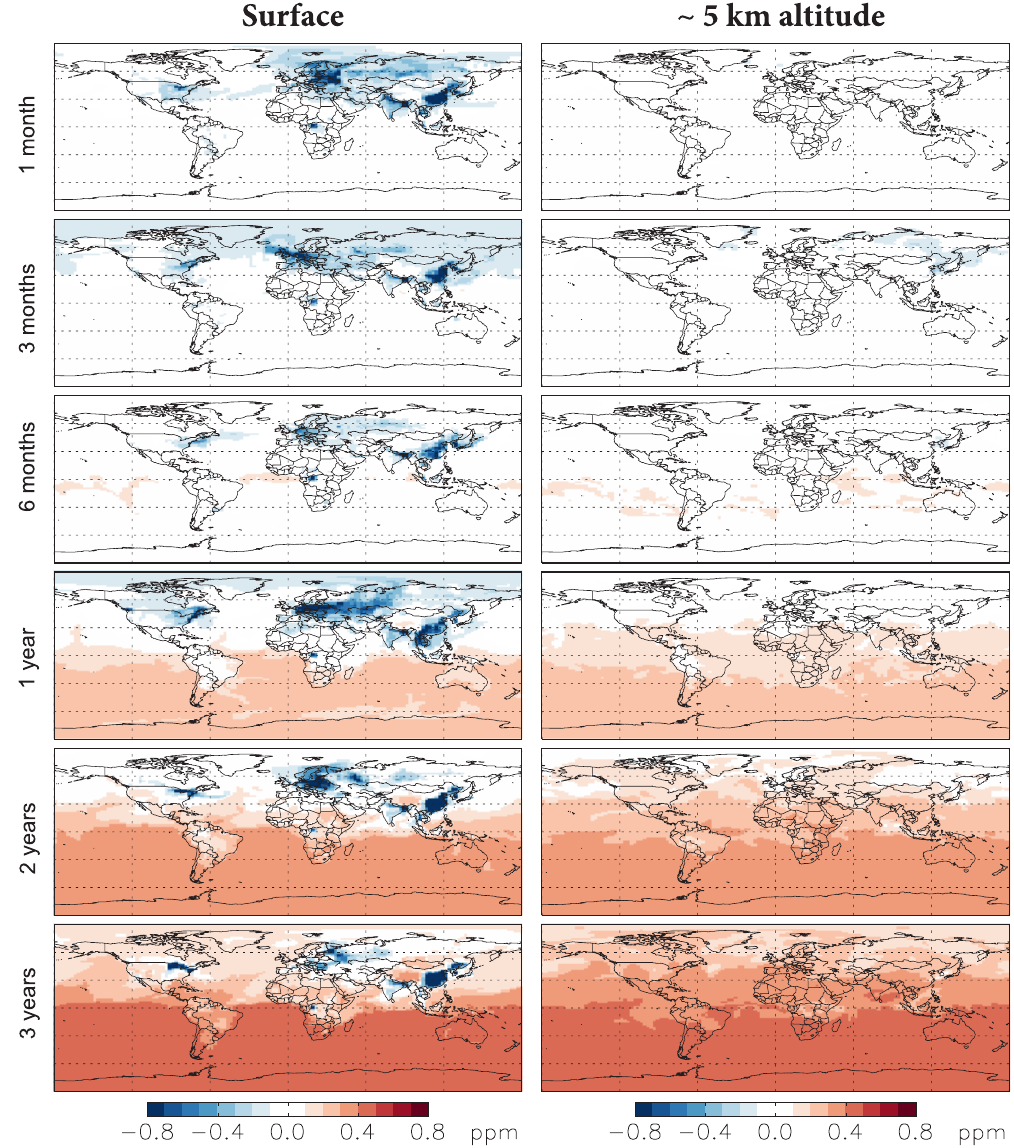
Fig. 8. Difference maps showing the impact of CO 2 chemical production and the surface correction (determined as: chemical source simulation – no chemical source simulation) at the surface and at the model level near 5km for increments up to 3years. The negative anomalies at the surface are a result of the surface